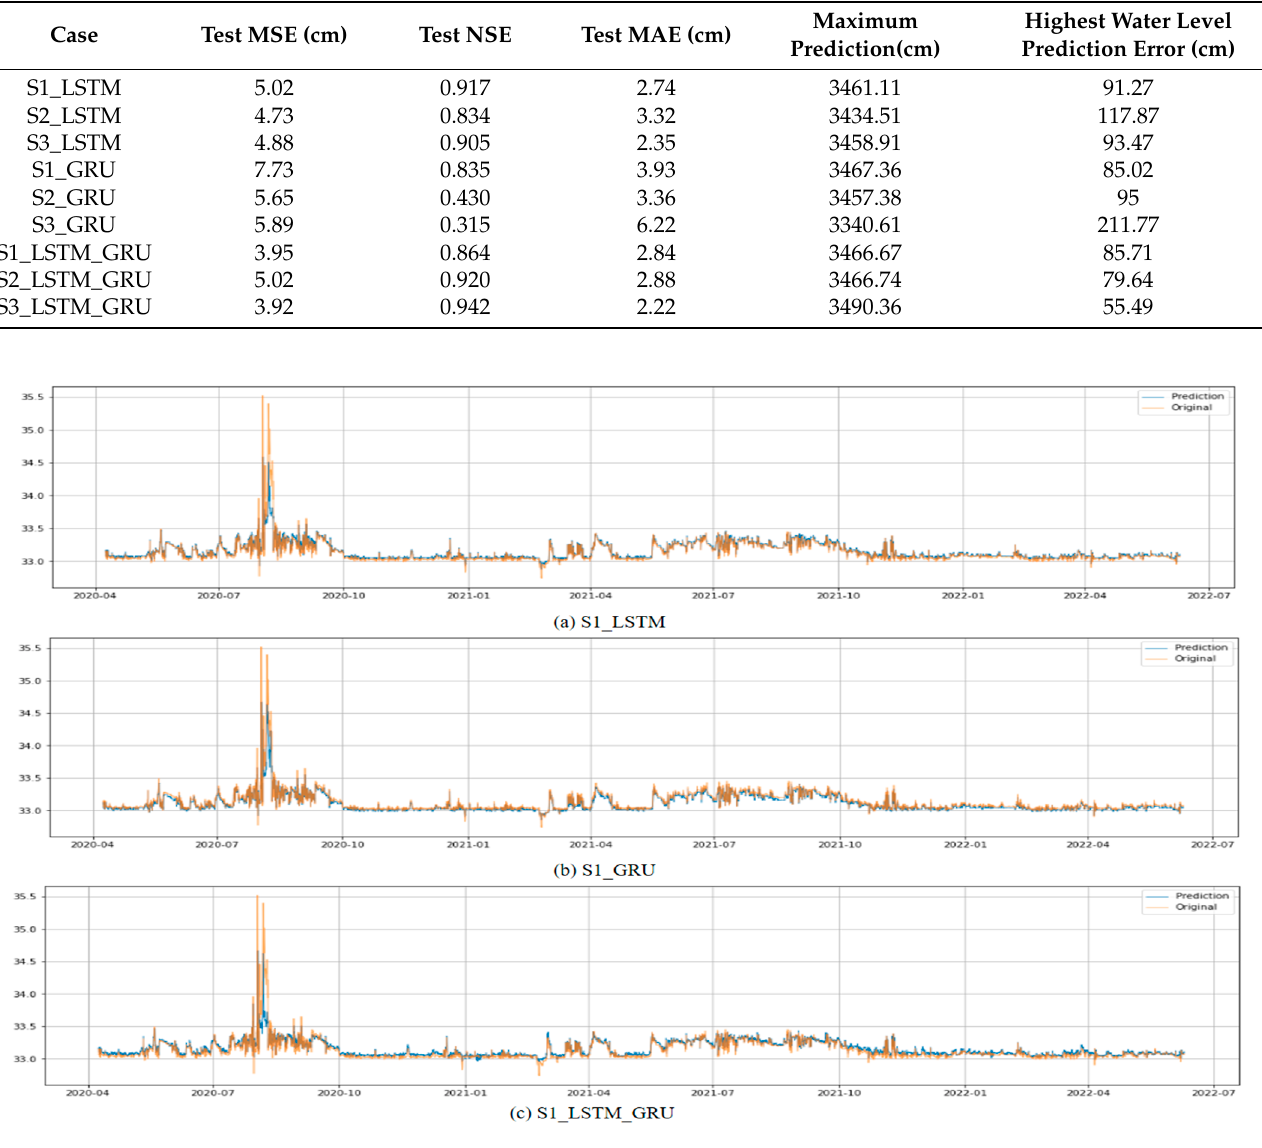
Figure 16. Comparison graph of observed and predicted values for each model in S2 case. ( a ) Multi- LSTM; ( b ) multi-GRU; and ( c ) LSTM–GRU.